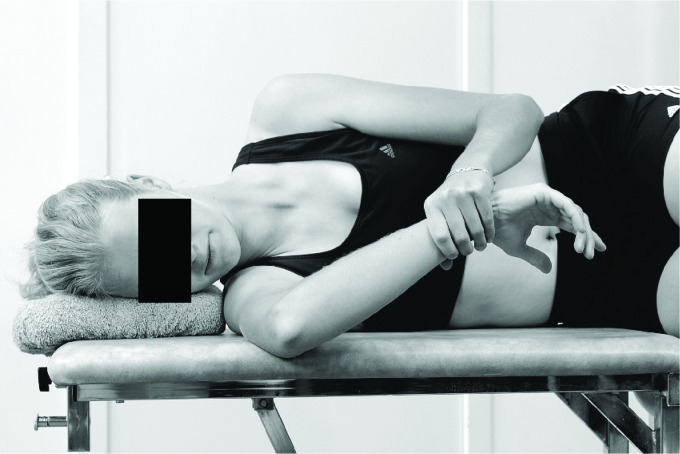
Sleeper's stretch41.